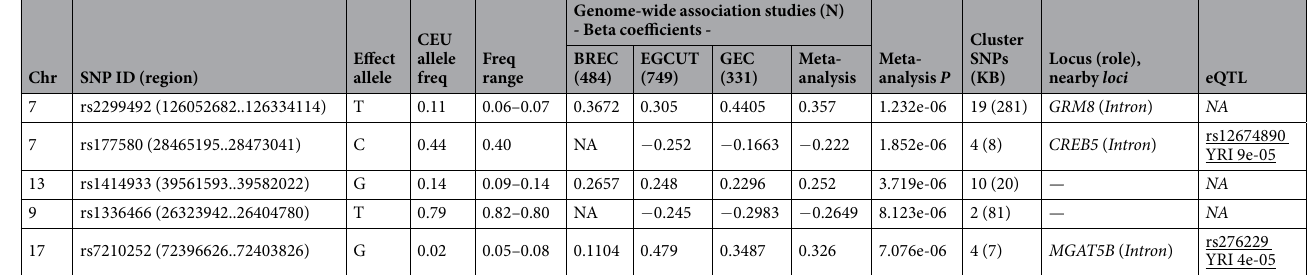
Table 1. Meta-analysis top cluster-index SNPs (P < 10 − 5 ) for associations across all investigated autosomal chromosomes. Index SNPs from 5 different associated genomic regions are shown. All SNPs listed are in Hardy-Weinberg equilibrium (HWE, P > 0.05), Criteria for clustering SNPs were physical distance threshold of 250 KB in relation to the index SNP, the extent of LD with it ( r2 > 0.5), and association P < 0.01. b The nearest reference locus is in bold typeface if the SNP cited is within it, and the role of the SNP is given between brackets. Reference loci are shown if any SNP of the cluster is located in a specific locus or within 20 KB up- or downstream of it. Chromosomes positions are based on the NCBI build 36. Total N for the meta-analysis was 1564, except for rs177580 and rs1336466 (N = 1080), for which results were not available for the BREC GWA. The effect (beta) was calculated based on either on the minor or the common allele, depending on the statistics packages used for the GWA analyses. eQTL = expression quantitative trait loci gene expression annotation